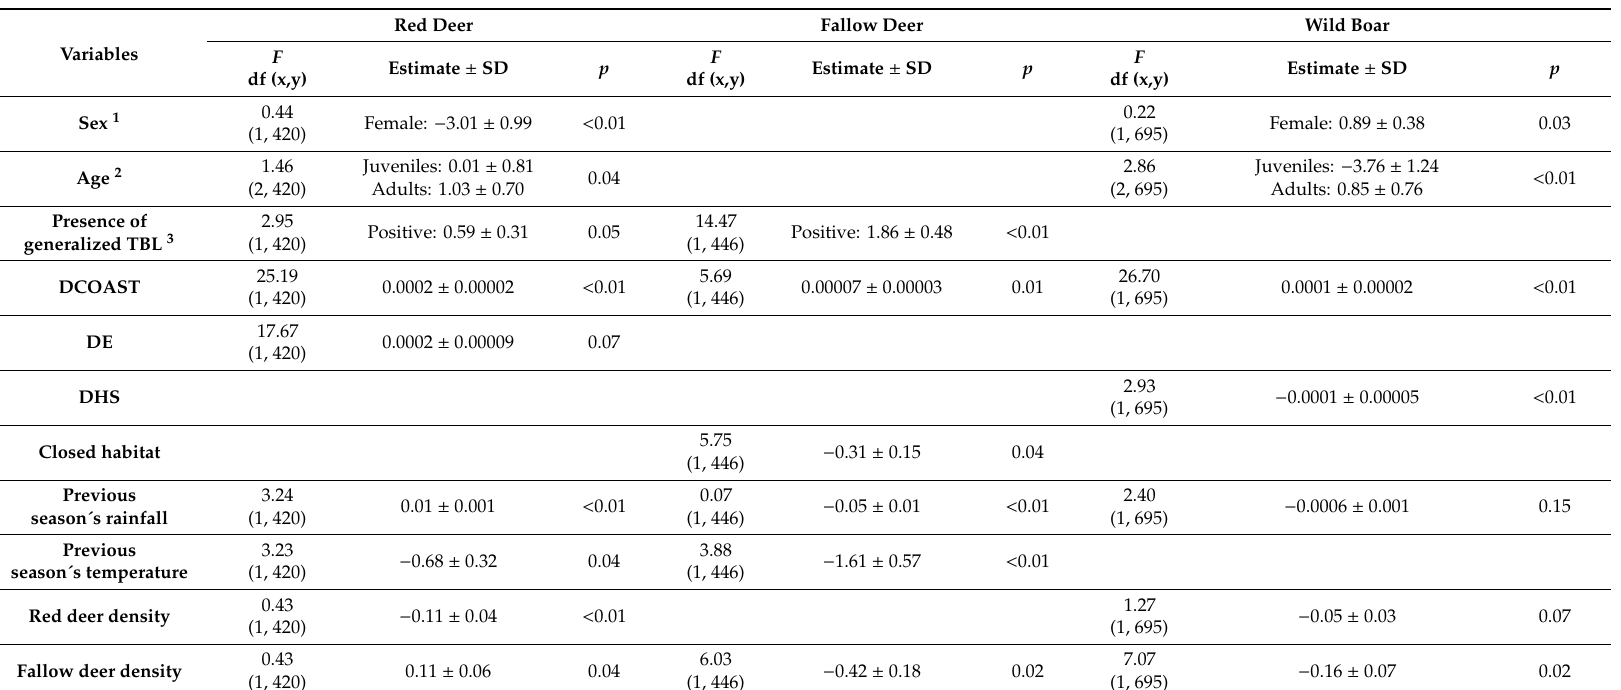
Table 1. Results of the GzLMMs of risk factors associated with seroprevalence of Toxoplasma gondii in each species studied related to sex, age class, straight-line distance to the nearest coastline (DCOAST), previous season´s rainfall and temperature, annual density of wild ungulates and livestock (horses and cattle), abundance of carnivores and Iberian lynx (KAI), presence of generalized tuberculosis-like lesions (TBL), cover level of closed habitat, straight-line distance to the nearest small human settlements (DHS), and two-ways interactions among them. The model was fitted using sampling season and sampling area as random factors. Parameter estimates for the level of fixed factors were calculated using a reference value of 0 for the male level in the variable sex, calves, and piglets for the variable age in deer species and wild boar, respectively, and negative for the variable presence of generalized